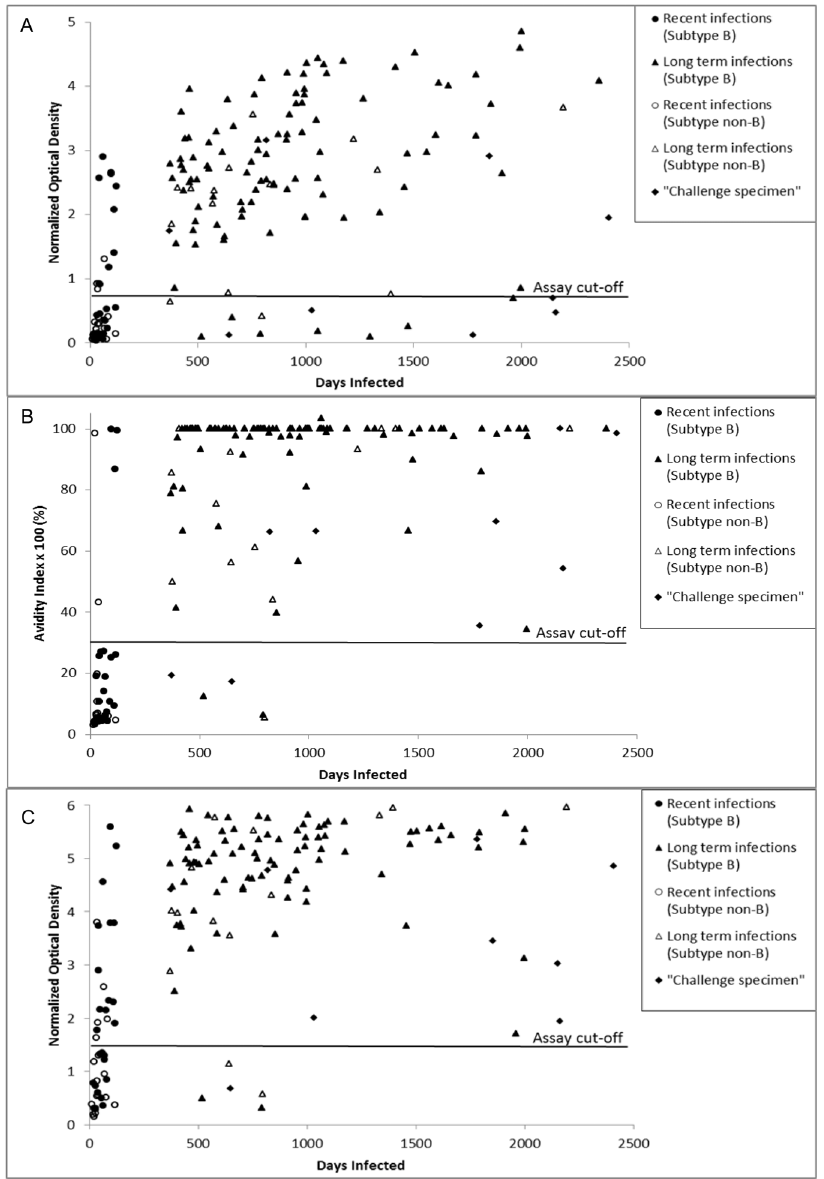
Figure 1. BED-CEIA, Bio-Rad Avidity and Lag-Avidity results according to duration of infection. Samples from the evaluation panel were analyzed using the BED capture enzyme immunoassay (A), Bio-Rad Avidity assay (B) and LAg-Avidity enzyme immunoassay (C). Respective assay cut- offs are indicated by the black line. Data are shown for subsets of the evaluation panel.